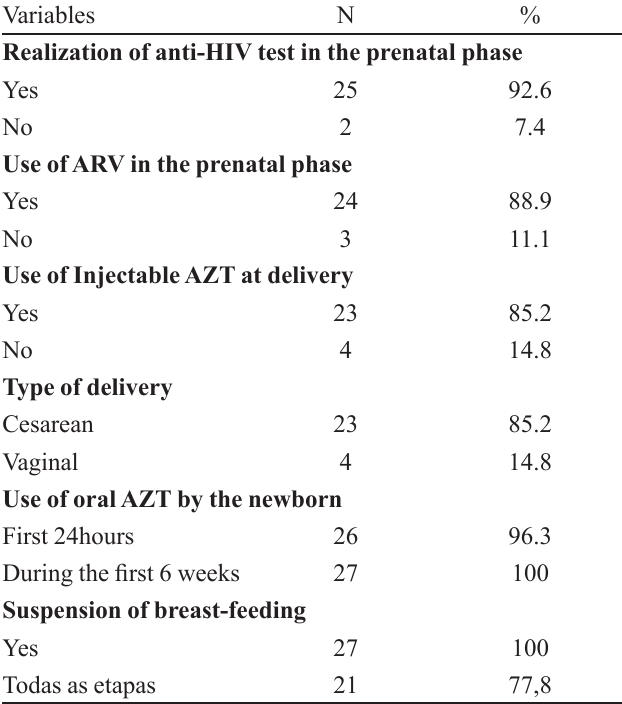
TABLE V - Classification of problems related to use of medications, or Drug Related Problems (DRP), identified according to Second Consensus of Granada (n=29)